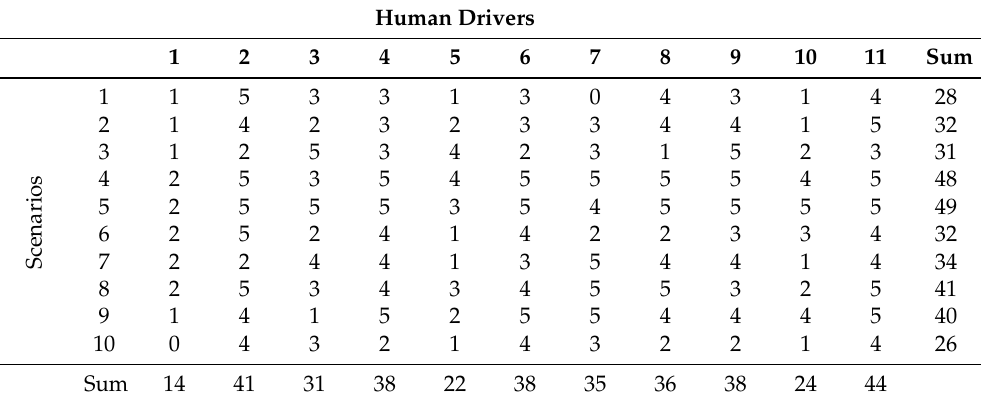
Table 3. Number of successful attempts of each driver on each scenario. Human